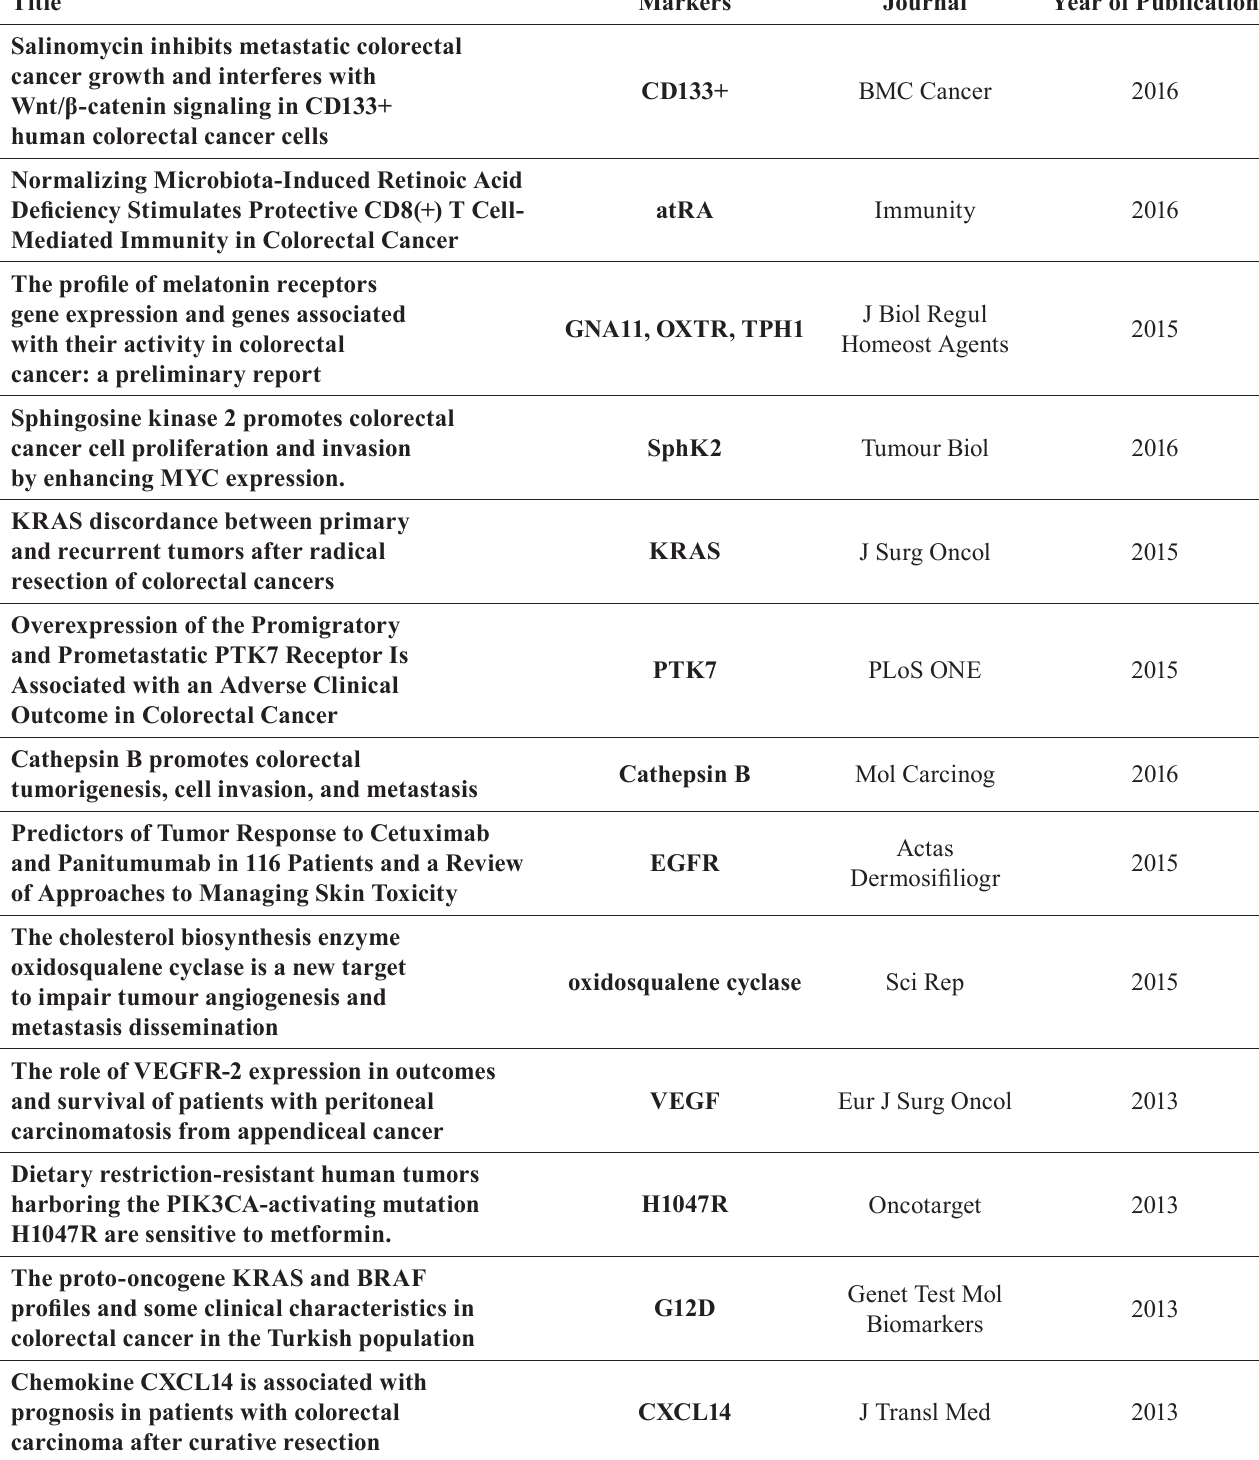
TABLE I - T umor targets of CRC identified in articles searched in PubMed, with their respective journals and year of publication